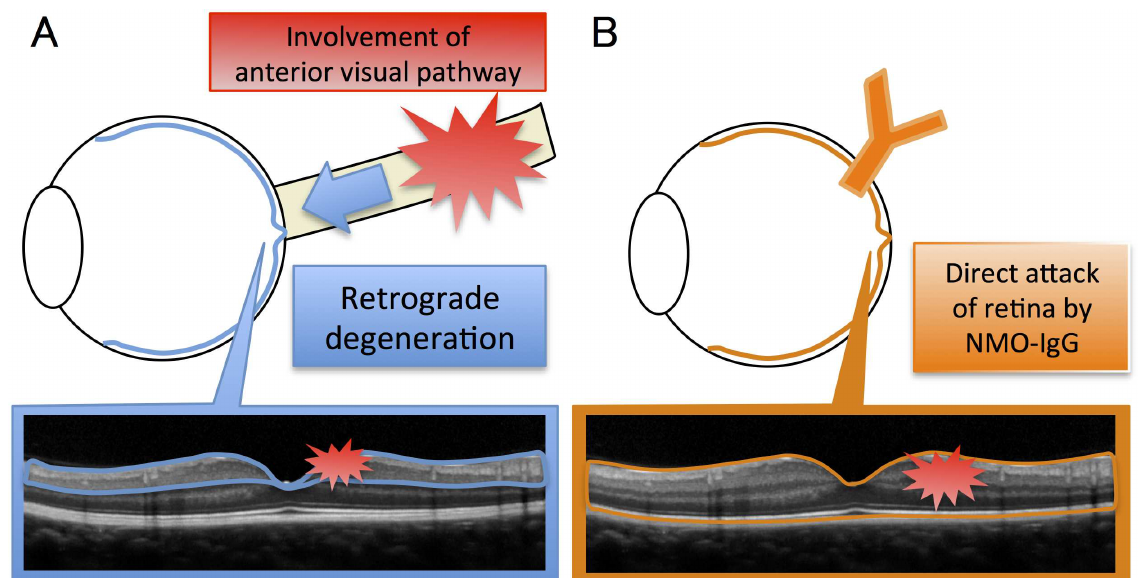
Fig 4. Hypothesis of different mechanisms between retrograde degeneration and direct retinal pathology. (A) In retrograde degeneration of neuromyelitis optica spectrum disorder(NMOSD), involvementof anterior visual pathway results in a thinningof the inner retinal layers includingthe retinal nerve fiber layer(RNFL) and ganglioncell-innerplexiformlayer (GCIP). (B) In direct retinal pathology of NMOSD, a direct attack of Mu¨ller cells by anti-aquaporin 4 (AQP4) antibodyresults in a secondary loss of retinal neurons includingONL